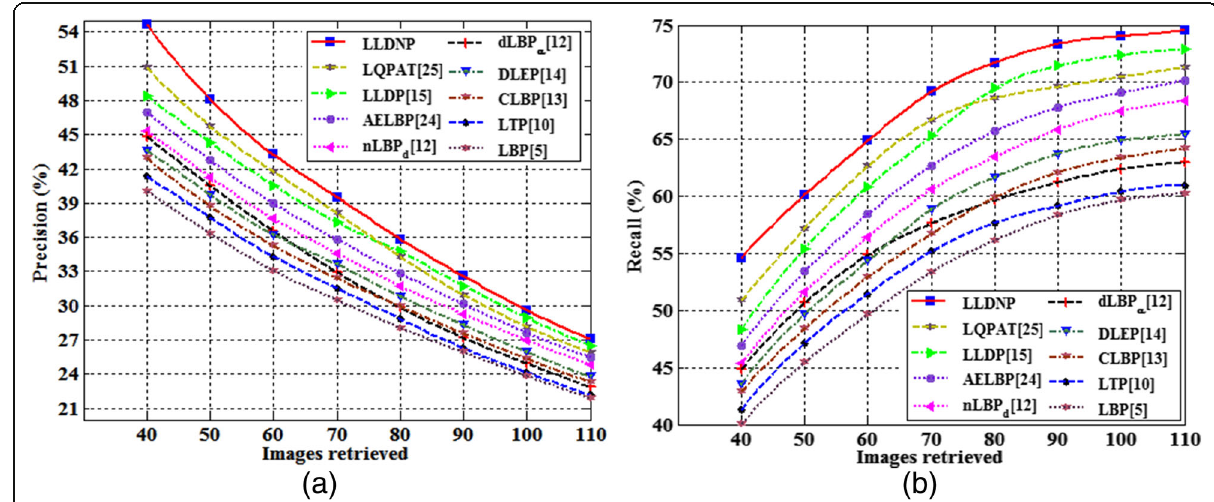
Fig. 16 Comparison of the proposed method with other existing methods in terms of a precision and b recall on UIUC database. The performance of existing methods and proposed LLDNP in terms of precision and recall is analyzed. The proposed LLDNP shows improved performance than the other existing methods on UIUC database